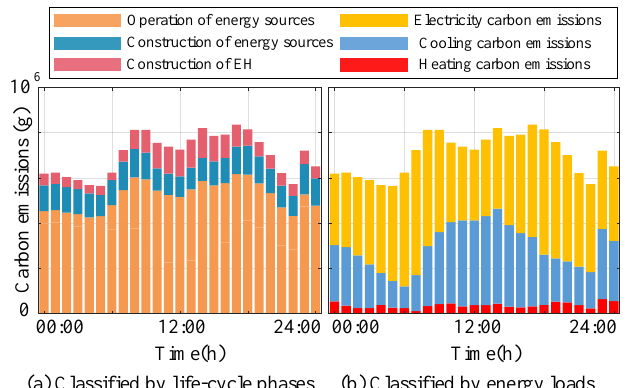
Figure 6. The carbon emissions of the UMES in 24 h of a summer weekday.